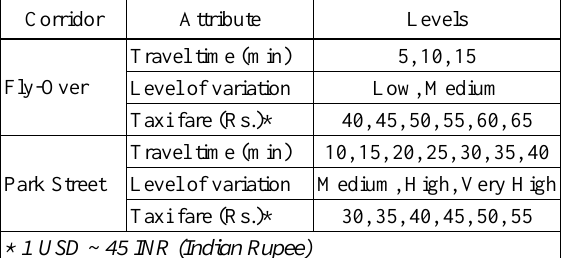
Table 2. Attributes and their levels for taxi trip makers